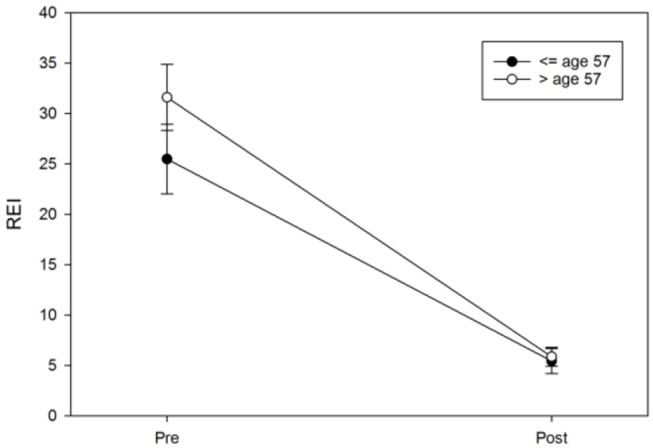
Age differences in pre-post REI trends. An age median split at 57 years was used only for illustrative purposes in this figure; the error bars represent the standard error.